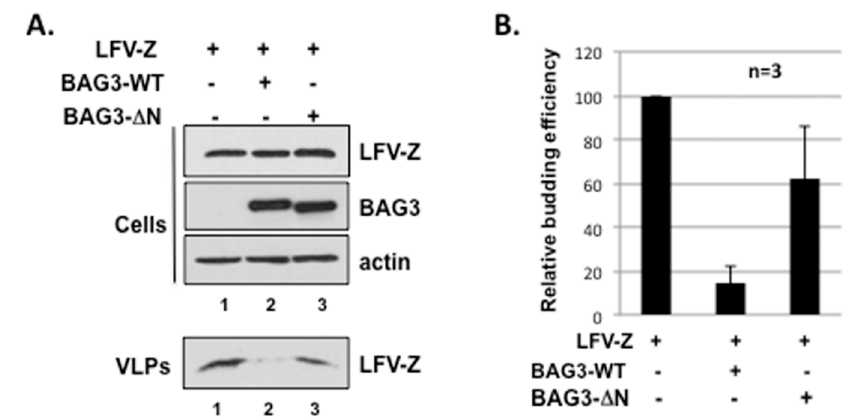
Figure 3. BAG3-WT protein inhibits LFV-Z VLP budding in a PPxY/WW-domain dependent manner. ( A ) Western blot analysis of cell extracts and VLPs from HEK293T cells transfected with LFV-Z alone (lane 1), or LFV-Z + BAG3-WT (lane 2) or BAG3- ∆ N mutant (lane 3); ( B ) Relative budding efficiency of LFV-Z VLPs in HEK293T cells transfected as indicated. Error bars represent the standard deviation of the mean from three independent experiments ( n = 3).